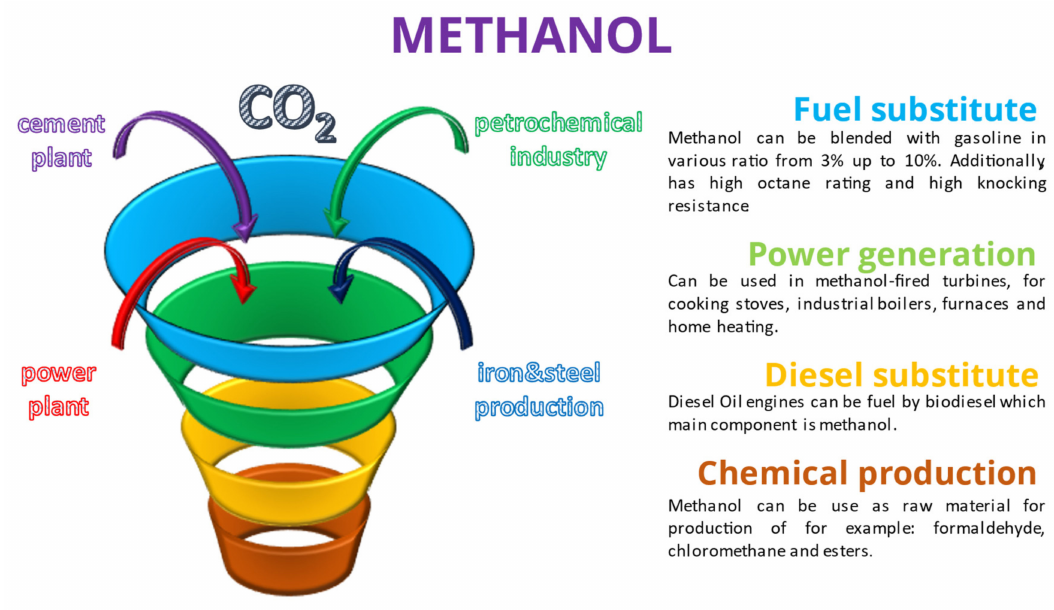
Figure 2. Applications of methanol